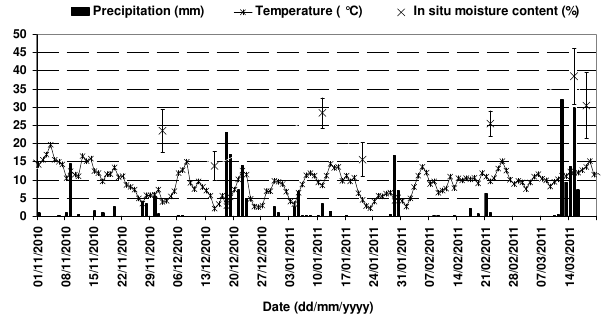
Fig. 7. Soil moisture contents from in situ measurements accord- Figure 7. Soil moisture contents from in situ measurements according to RADARSAT-2 2 ing to RADARSAT-2 acquisition dates, and meteorological data acquisition dates, and meteorological data (daily precipitation and mean daily temperature). 3 (daily precipitation and mean daily temperature). Precipitation and Precipitation and air temperature were taken from a meteorological station installed in the 4 air temperature were taken from a meteorological station installed basin (near Sète city). 5 in the basin (near S`ete